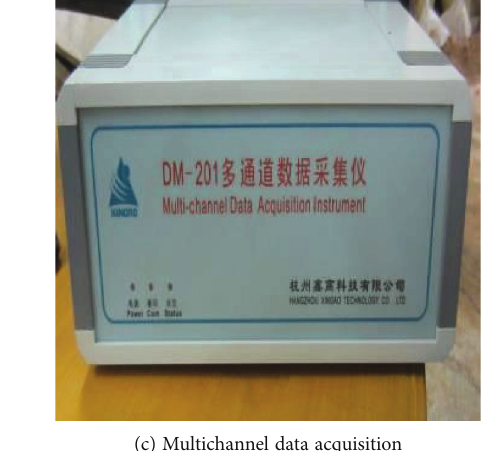
Figure 2: Monitoring instruments and its arrangement for soil